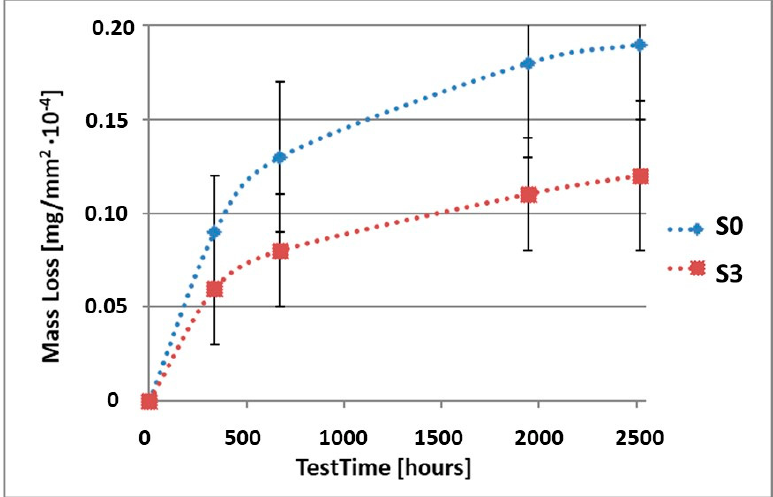
Figure 8. Comparison of the mass losses of samples S0 and S3 for tests in CASS environment.